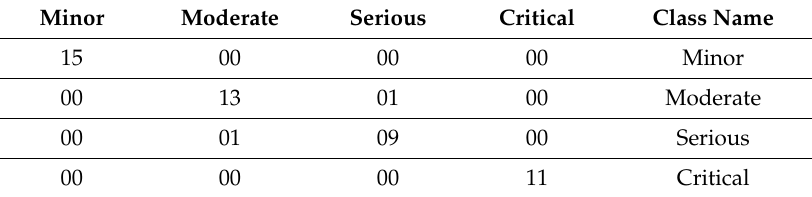
Table 20. Confusion Matrix for fold 4.